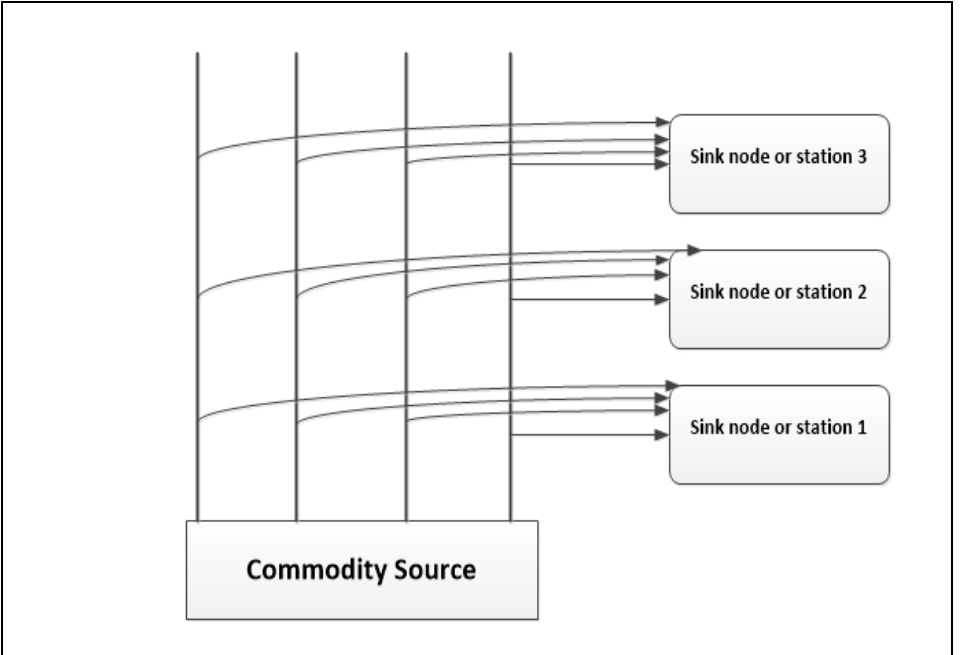
Figure 1. A commodity-supply system that is modeled as a multi-state k-out-of-n: G system (Adapted from Tian et al.,